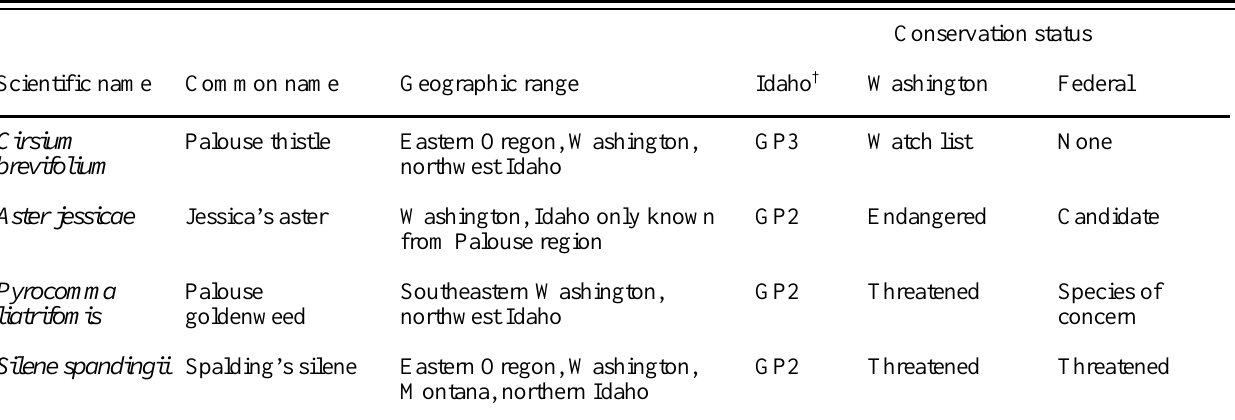
Table 2 . Species of special conservation concern on the